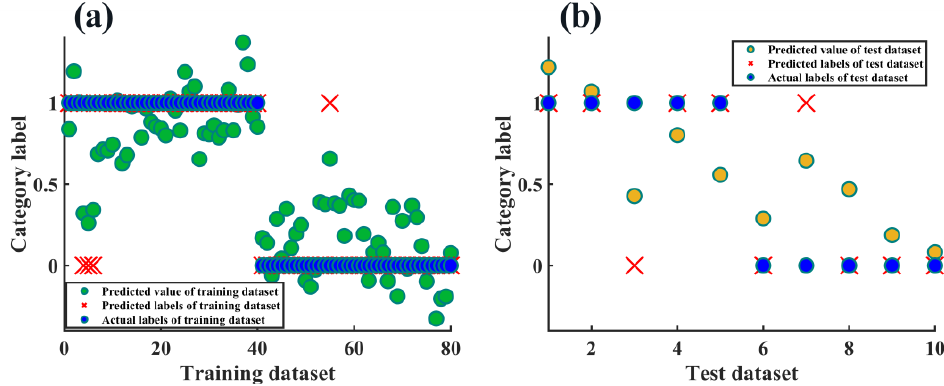
Figure 8. Classification results of ( a ) training dataset and ( b ) test dataset using PLS-DA method.